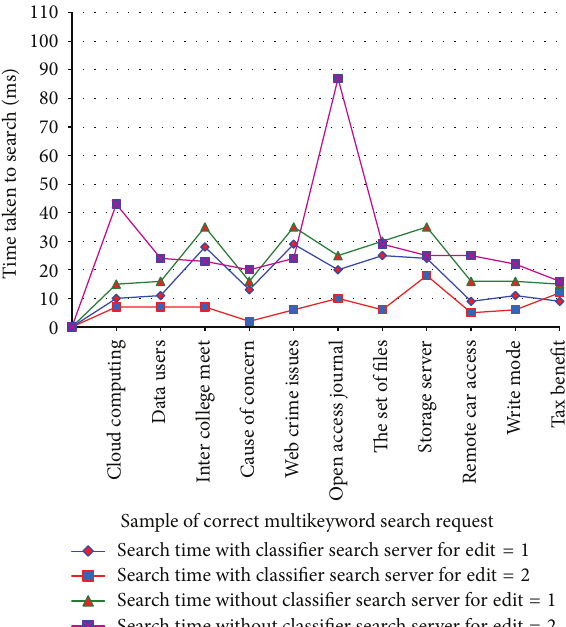
Figure 6: Search efficiency for correct keywords in